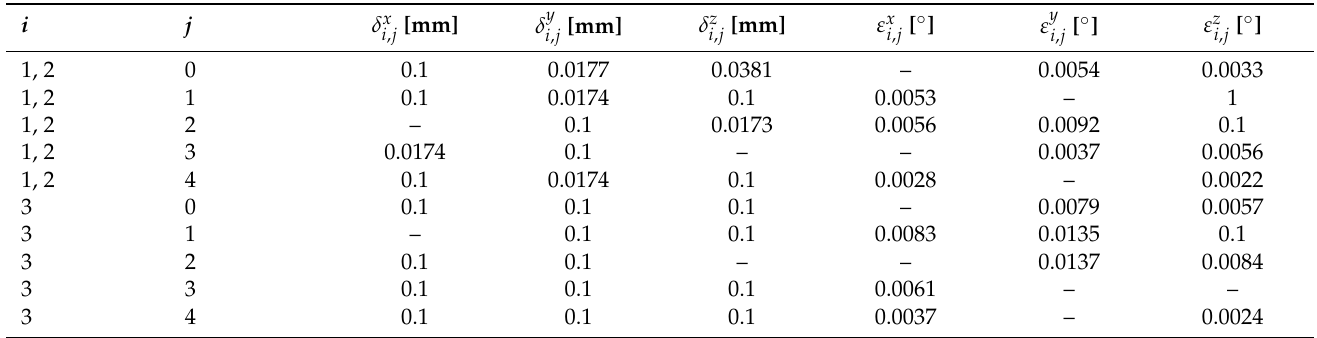
Table 10. Specified geometric errors for verification.